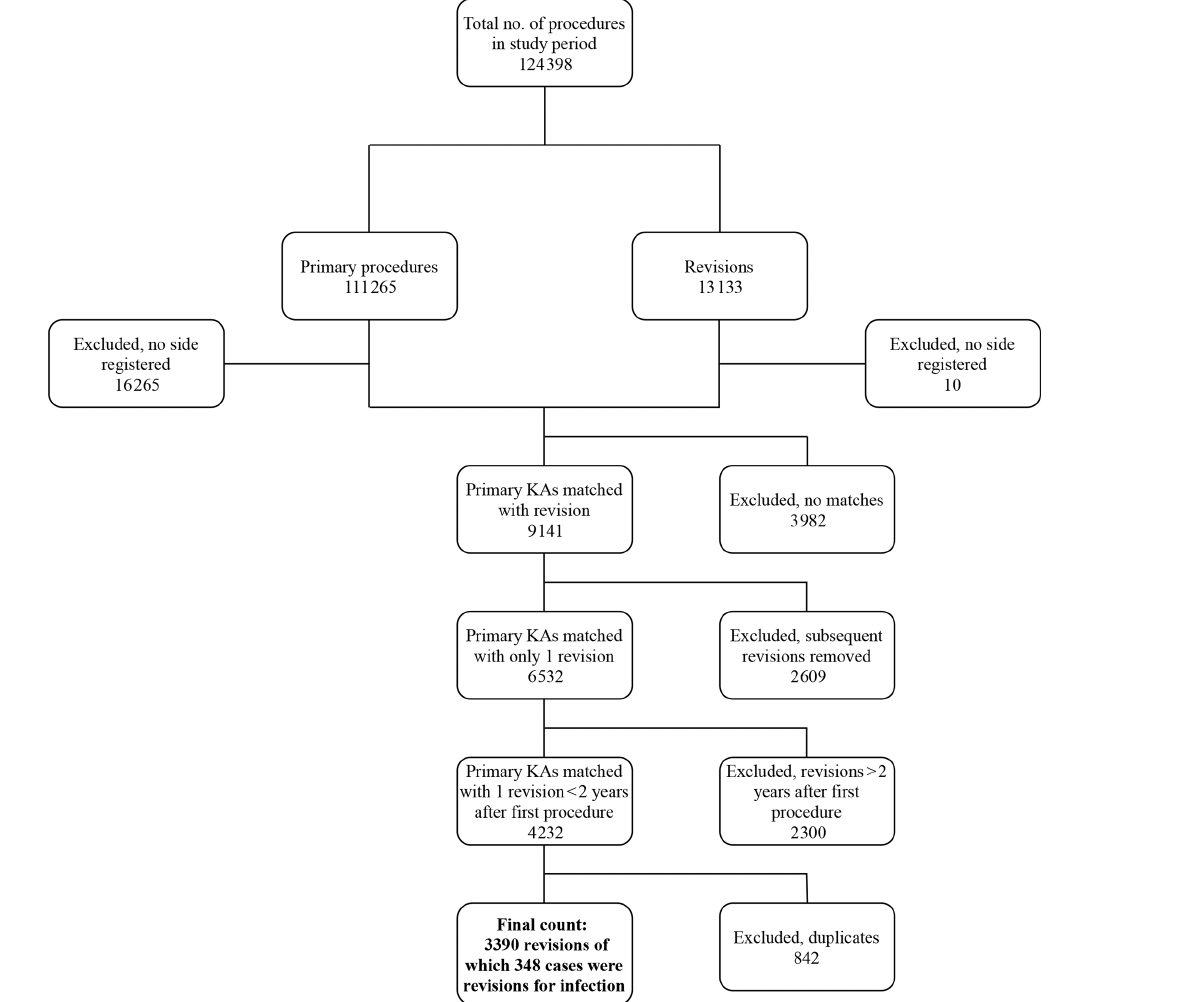
Figure 1. Flowchart describing the data-collection